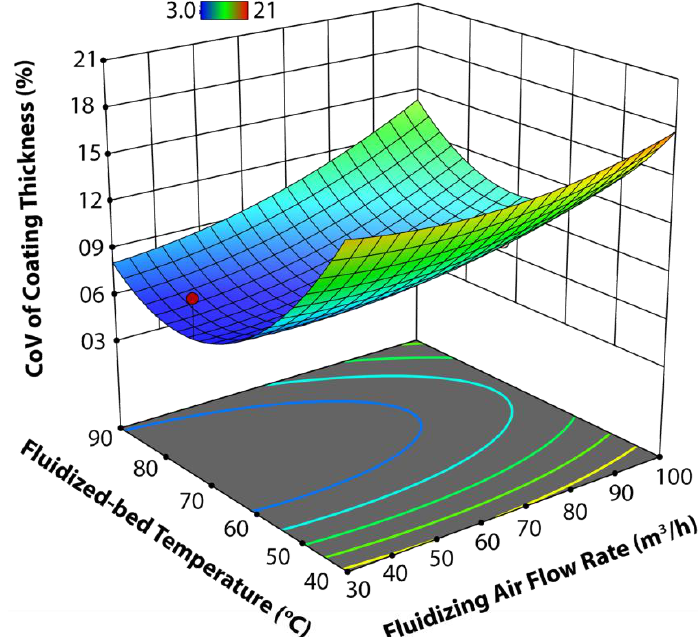
Figure 3. Interactive effect of the fluidized-bed temperature ( T fb ) and fluidizing air flow rate ( Q air ) on the coefficient of variance (CoV) of the coating film thickness.